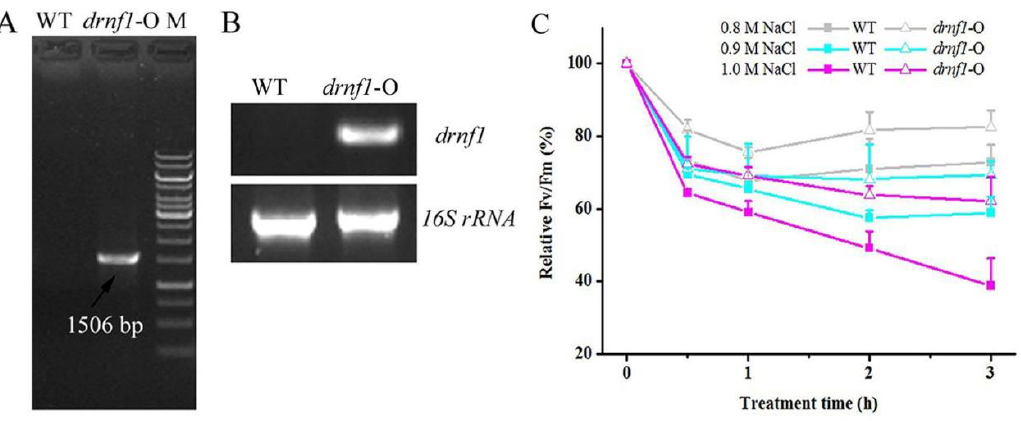
Figure 2. Identification of transgenic drnf1 Synechocystis and its resistance to short-term salt stress. ( A ) Identification of the transgenic strain using drnf1 gene-specific primers by PCR. WT: wild-type strain. drnf1 -O: transgenic strain. M: DNA marker. ( B ) Semi-quantitative RT-PCR detection of drnf1 transcription in the transgenic strain. ( C ) Changes of relative Fv/Fm during salt stresses for 3 h. Data are mean ± s.d. ( n = 5).